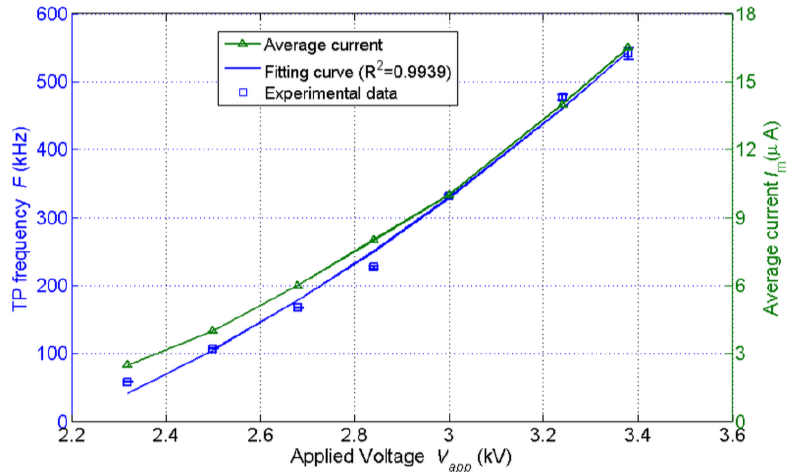
Figure 7. Variations of TP frequency and average current with applied